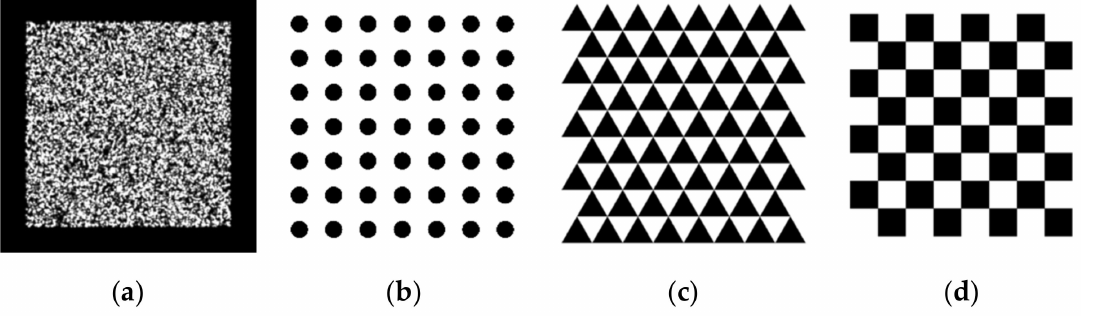
Figure 7. Two-dimensional targets used in the experiment, containing: ( a ) speckle pattern calibration target; ( b ) circular pattern calibration target; ( c ) triangle pattern calibration target; ( d ) chessboard pattern calibration